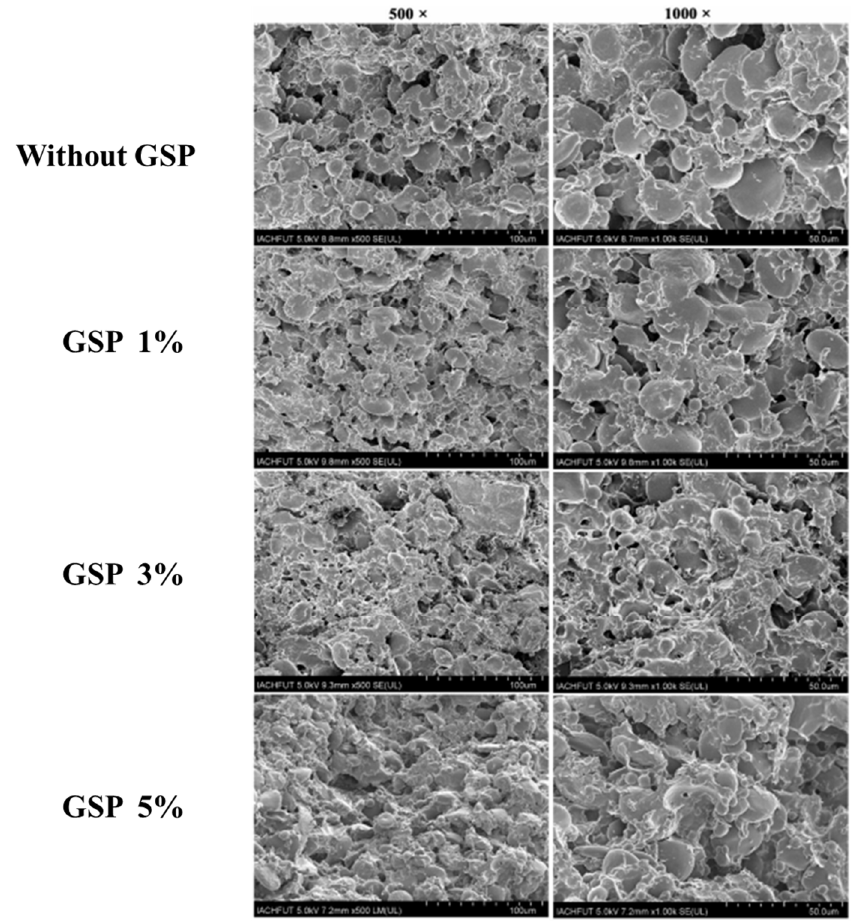
Figure 5. Role of grape seed power in the structural properties of the gluten network of noodles. Adapted with permission from ref. [1]. 2021, Elsevier.